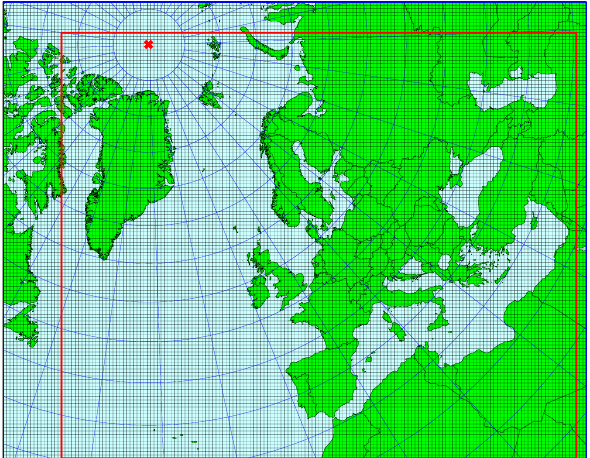
Fig. 2 . Standard computational domain of the EMEP Unified model (external frame) and Fig. 2. Standard computational domain of the EMEP Unified model reduced domain (internal red frame) where computations of nitrogen deposition were (external frame) and reduced domain (internal red frame) where performed for the period 1995-2006. computations of nitrogen deposition were performed for the period